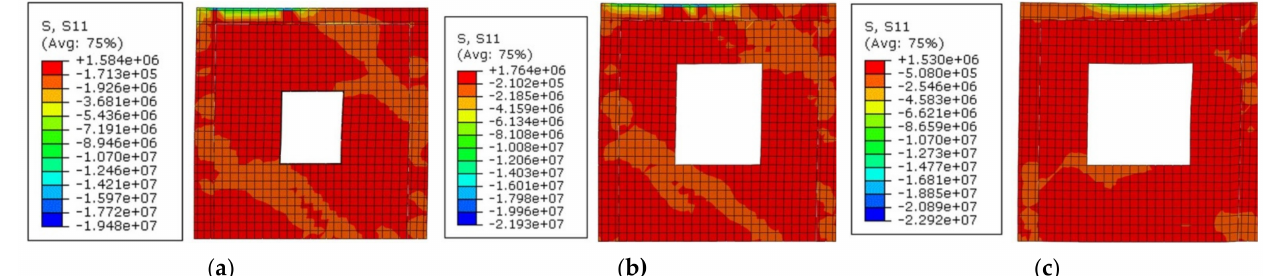
Figure 24. Stress nephogram of the walls with different window holes’ dimensions: ( a ) wall ZWZ-4; ( b ) wall ZWZ-5; ( c ) wall ZWZ-6.